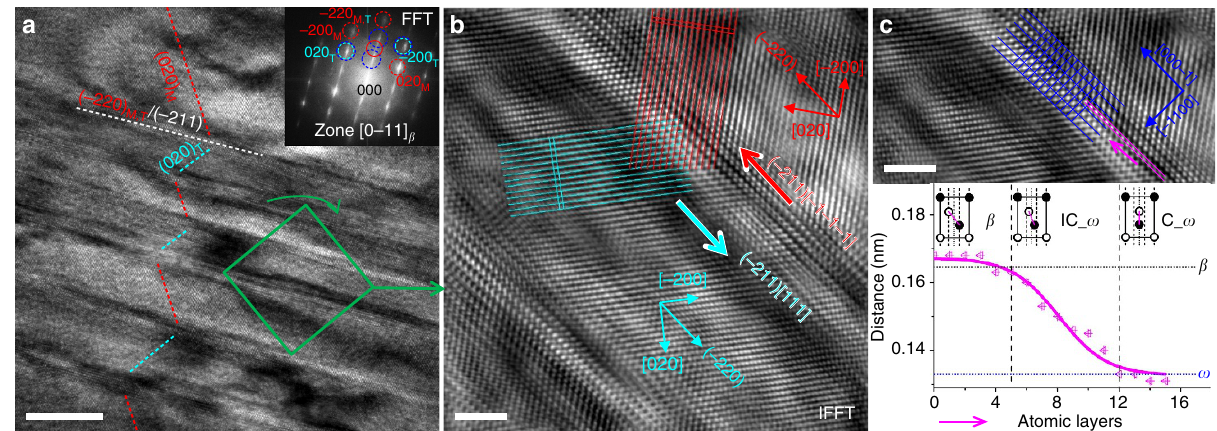
Figure 3 | HRTEM images of a 00 CTand a – o planar complexion. ( a ) Low-magnification HRTEM image; the inset shows the corresponding FFTdiffraction pattern (scale bar, 10nm). ( b ) Atomic configuration of a 00 CT, where red and cyan arrows with white background represent the shear and accommodation directions of a 00 matrix and its twin during transformation. ( c ) Analysis of atomic configuration within a – o planar complexion: b - IC_ o (incommensurate o ) - C_ o (commensurate o ), where the inset is the plot of atom distance between the middle atoms along the purple lines. Scale bars, 2nm ( b , c